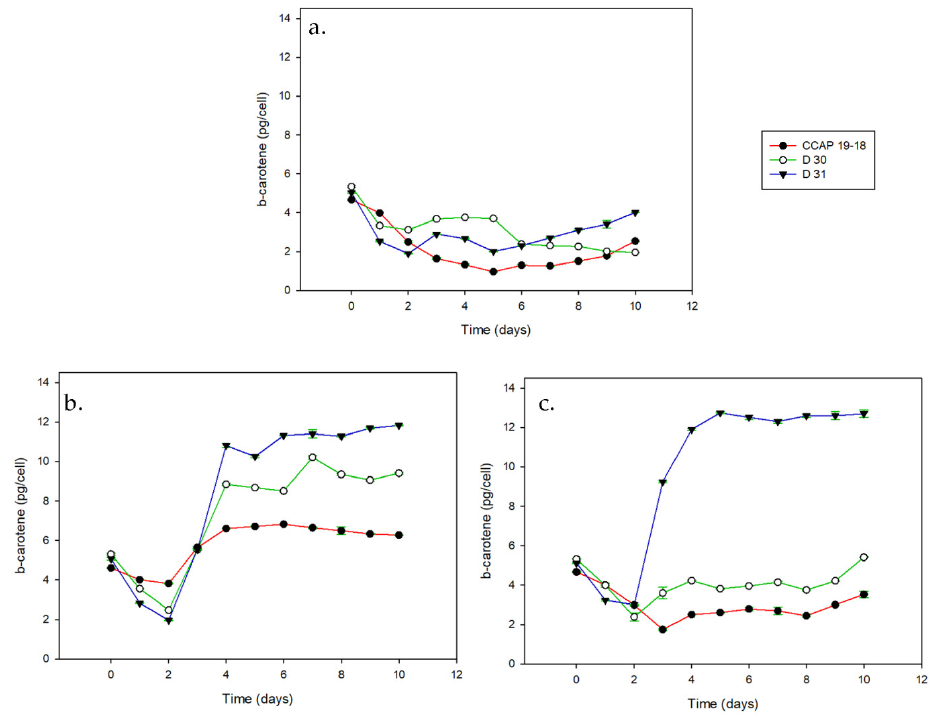
Figure 5. Daily changes in the β -carotene content of the cells (pg · cell − 1 ) of the studied strains cultivated in different conditions: ( a ) standard conditions, ( b ) nitrogen deprivation and ( c ) salinity stress (SE, n = 3).